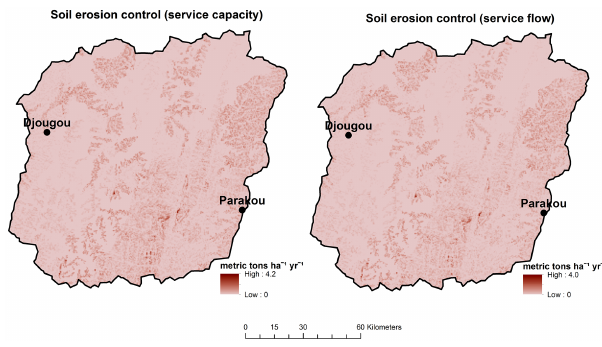
Figure 8. Spatial distribution of mean annual values of service ca- pacity and service flow of soil erosion control in the Upper Ouémé watershed from 2001 to